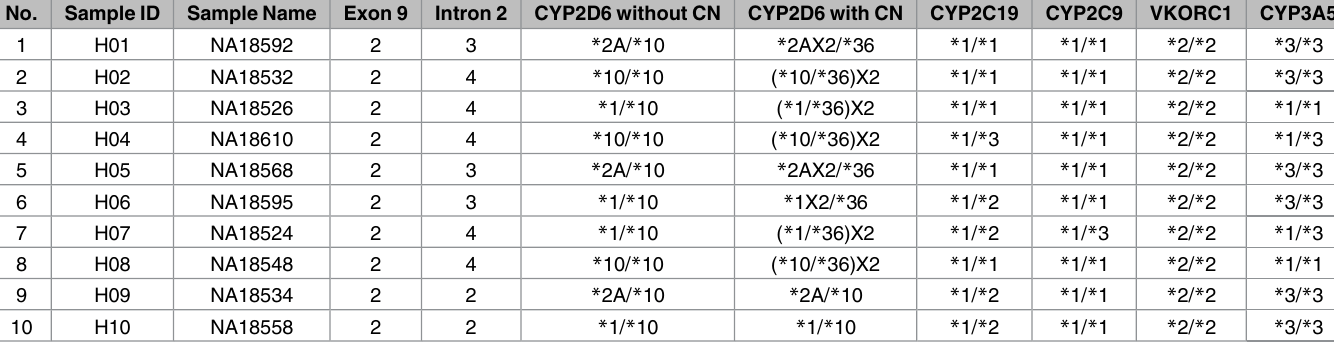
Table 2. Haplotype calls of 10 HapMap samples used for assay